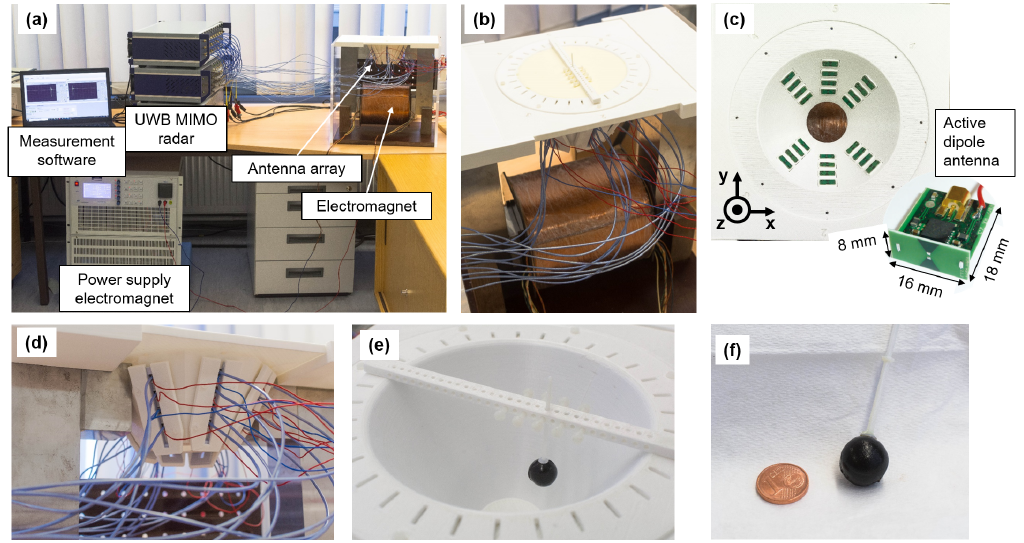
Figure 3. UWB microwave imaging setup via modulated MNPs: ( a ) Measurement setup. ( b ) Examination mold filled with the tissue-mimicking material (cream) and the target inside. ( c ) Top view of the antenna array showing the arrangement of the small active dipole antennas. ( d ) Antenna array in the air gap with the antenna attachment. ( e ) Examination mold with the tumor-mimicking target, which is positioned by means of a holder. ( f ) Target with a volume of 2 mL and an MNP concentration of 25